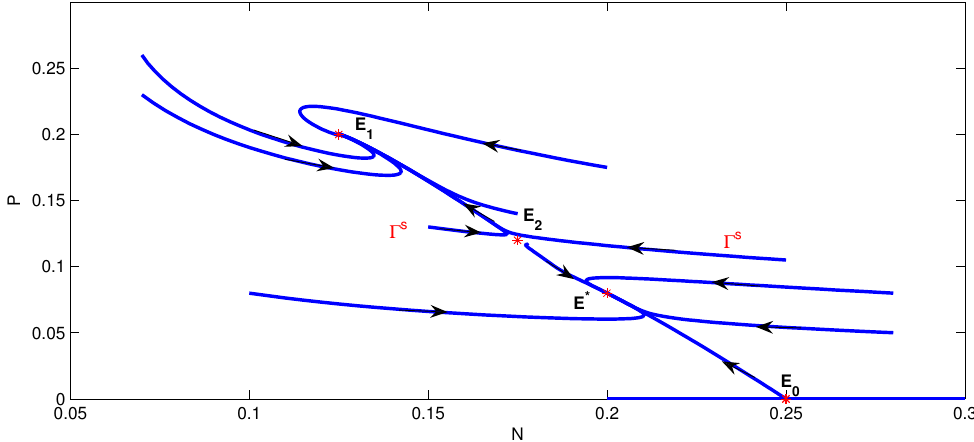
Figure 7. The phase portrait of model Equation (3) with bistable positive equilibria E ∗ and E 1 , and unstable equilibria E 0 and E 2